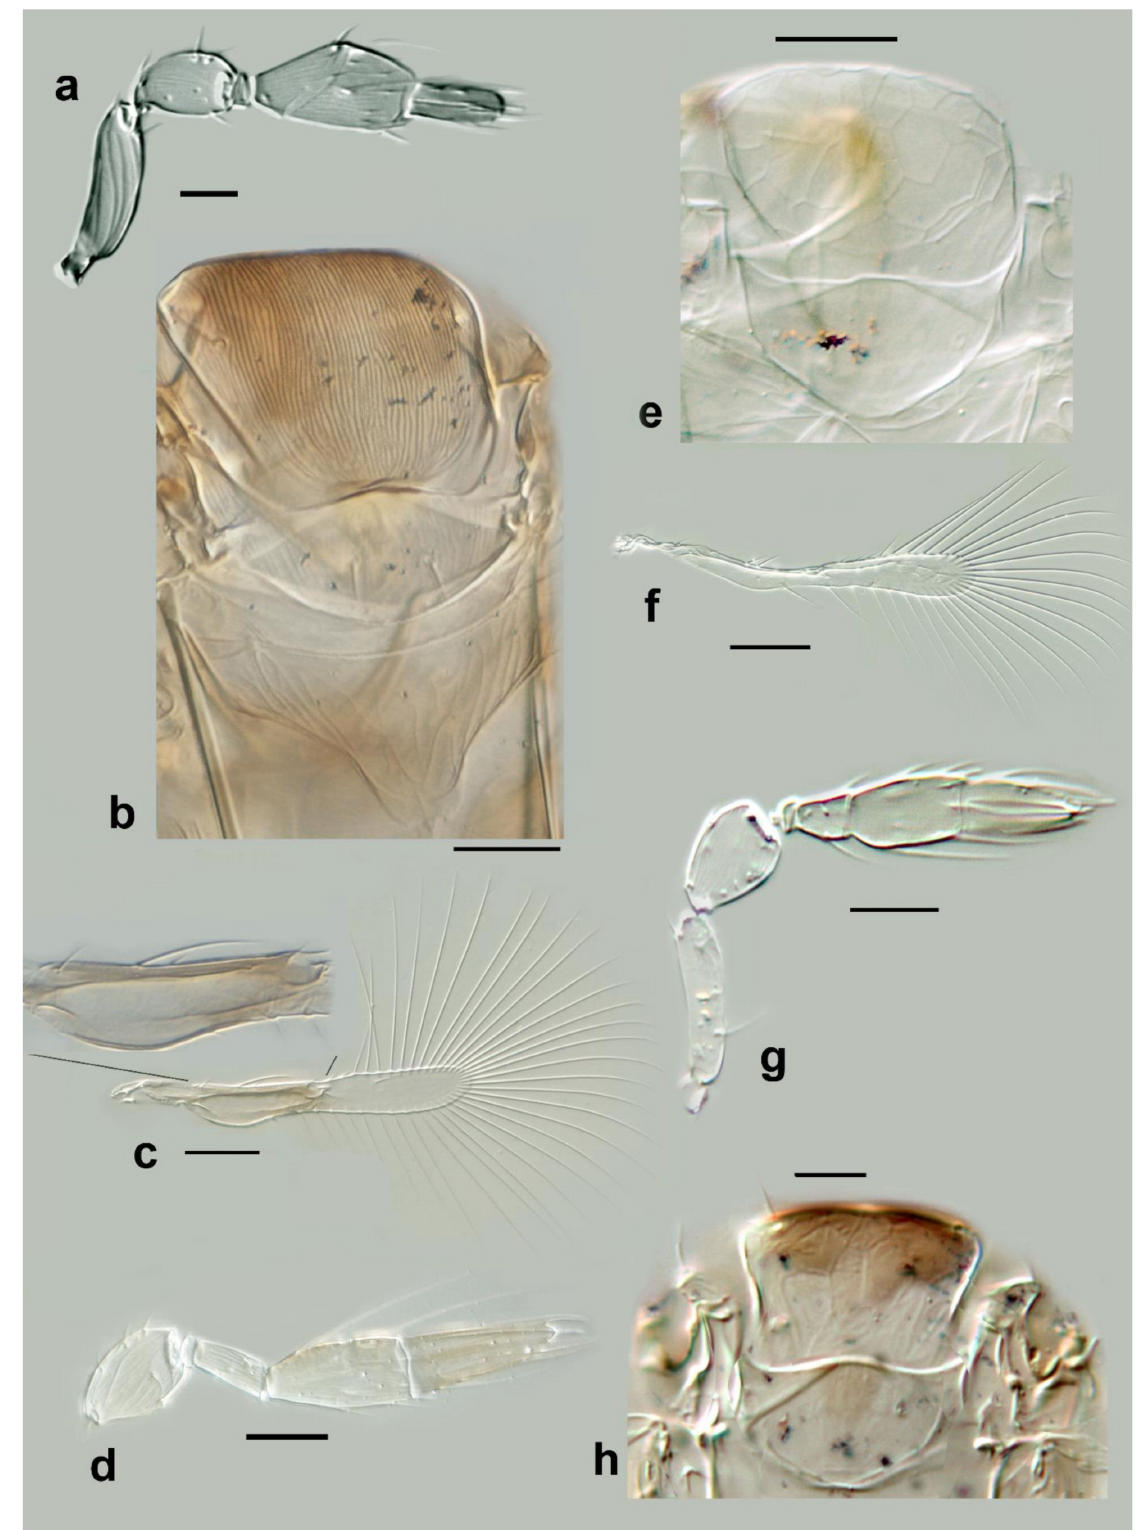
Figure 14. Photographs of Megaphragma species: ( a ) M. digitatum , female antenna (Holotype); ( b ) M. digitatum , female dorsal mesosoma (Holotype); ( c ) M. digitatum , female fore wing (Holotype); ( d ) M. fanenitrakely , female antenna (Holotype); ( e ) M. fanenitrakely , female mesosoma (Holotype); ( f ) M. fanenitrakely , female fore wing (Holotype); ( g ) M. funiculatum , female antenna (Holotype); ( h ) M. funiculatum , female mesosoma (Holotype). Scale bars 20 µ m except 50 µ m for c and